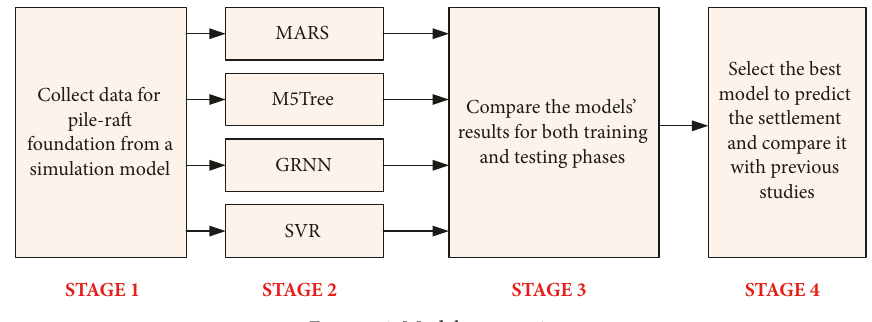
Figure 4: Models processing.